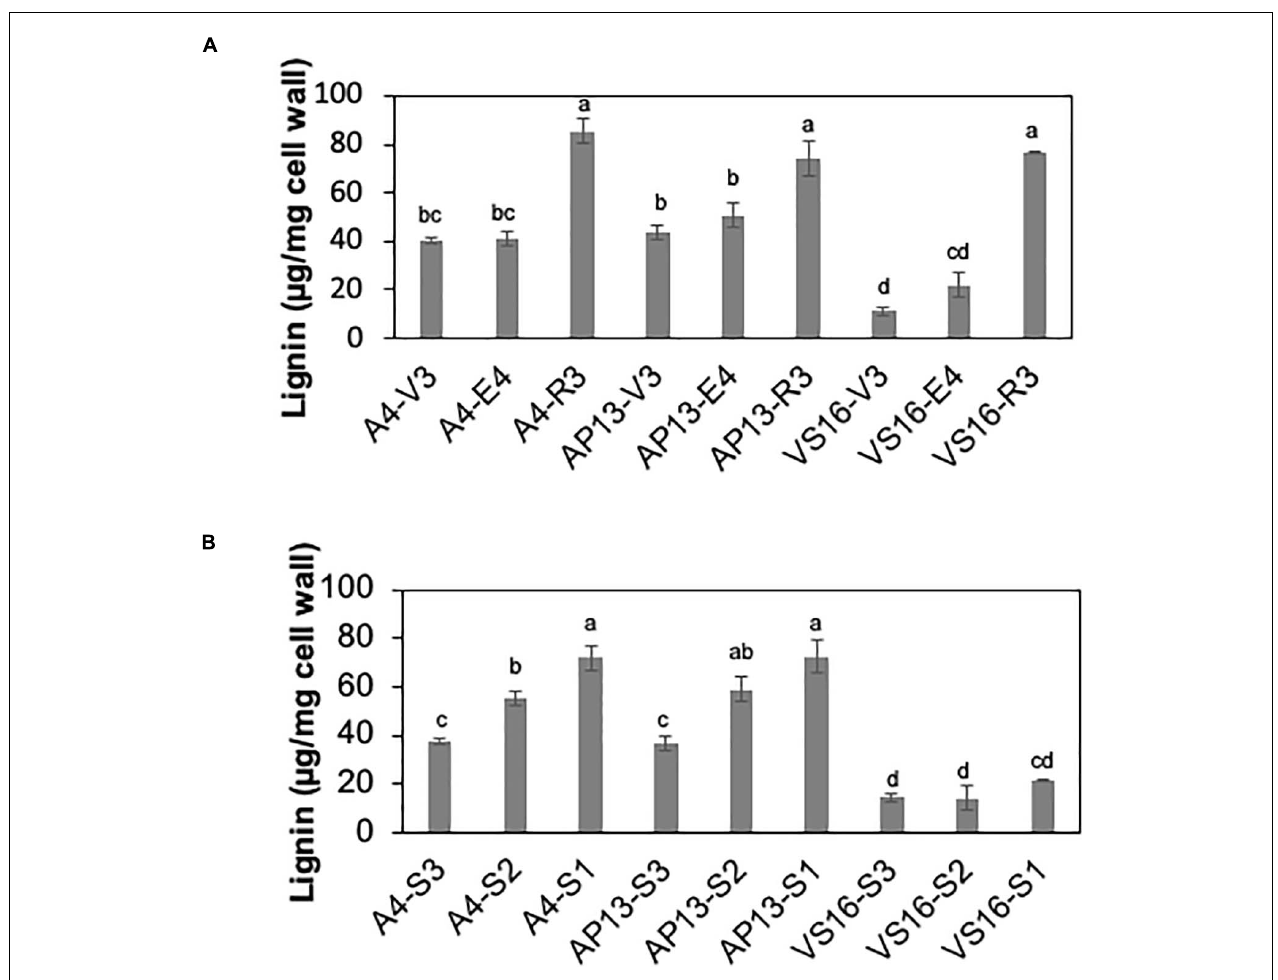
FIGURE 2 | Lignin of switchgrass genotypes A4, AP13, and VS16. Samples are arranged from developmentally young tissues to old tissues. (A) Whole tillers at V3, E4, and R3 developmental stages and (B) S3, S2, and S1 tissue segments of the E4 tiller as shown in Figure 1 . Error bars indicate standard error ( N = 3). Means with unshared letters are likely to be significantly different [Tukey’s honestly significant difference (HSD), P ≤